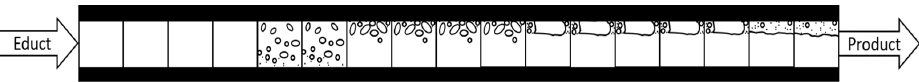
Table 2. Exemplary test runs performed in the pilot plant. The total number of test runs was 67.